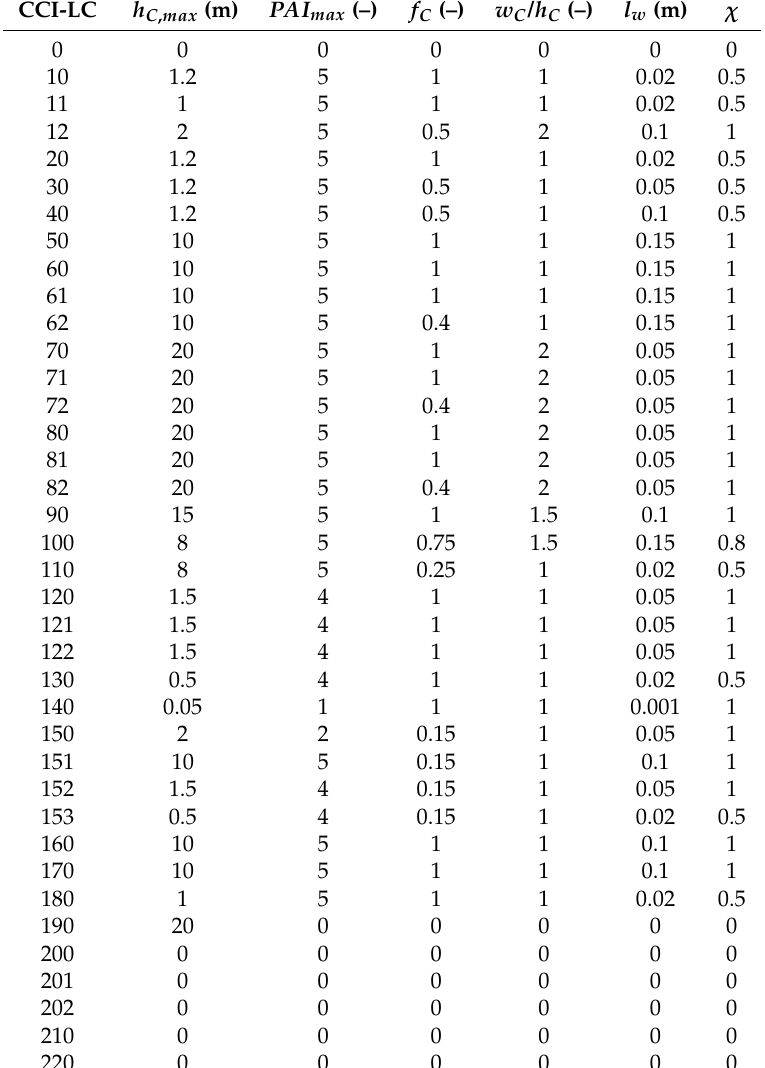
Table 2. Land cover based Look-Up-Table for ancillary parameters used in ET models. CCI-LC is the land cover code for the ESA’s CCI land cover legend